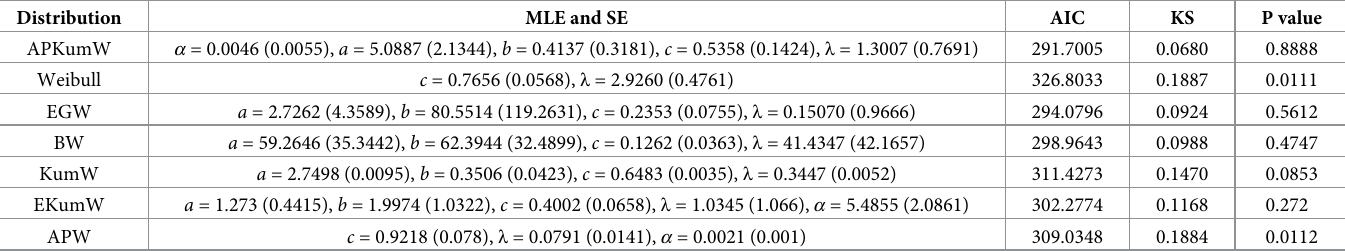
Table 3. MLEs, (SEs) for the parameters and associated goodness of fit statistics for the acute bone cancer data. Distribution